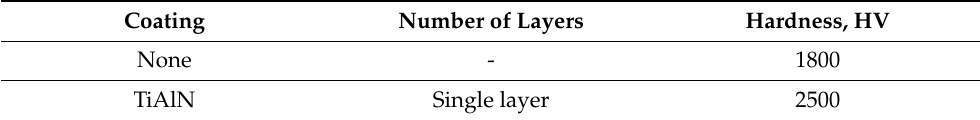
Table 1. Representation of the hardness measurement result, HV.